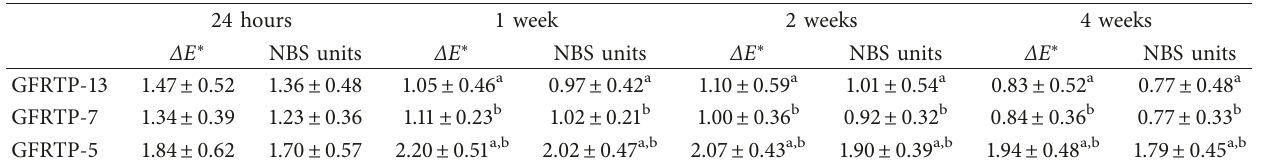
Table 6: Color differences measured in ΔE ∗ and NBS units after immersion in coffee